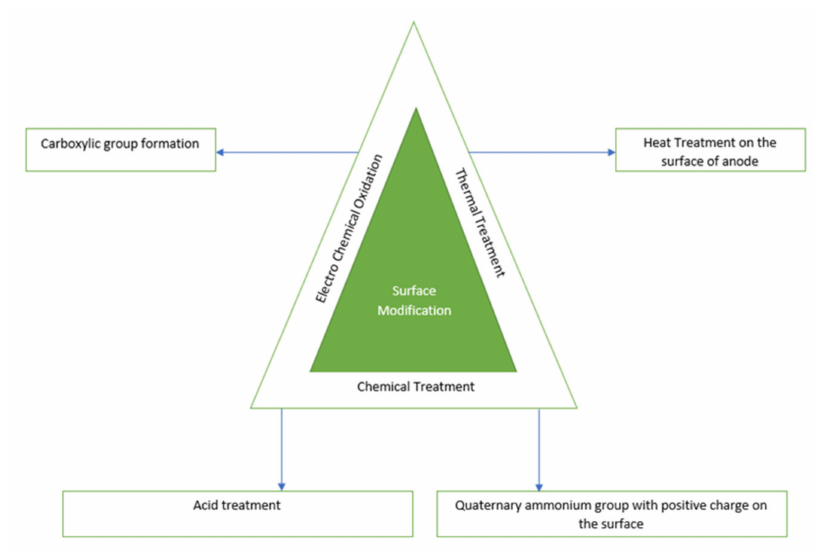
Figure 3. Classification of surface-modified anode based on the physicochemical